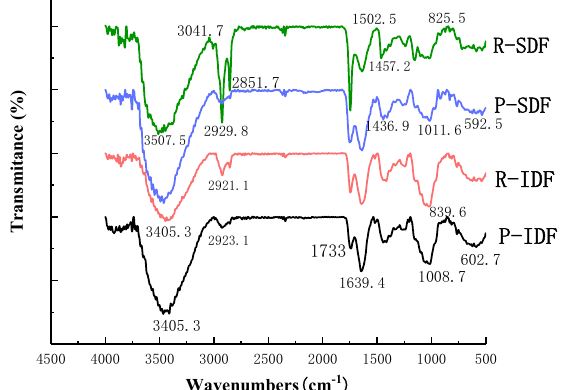
Figure 2. FT-IR spectra for IDFs and SDFs. R-SDF represents the residue soluble fiber; P-SDF represents the peel soluble fiber; R-IDF represents the residue insoluble fiber; P-IDF represents the peel insoluble fiber.